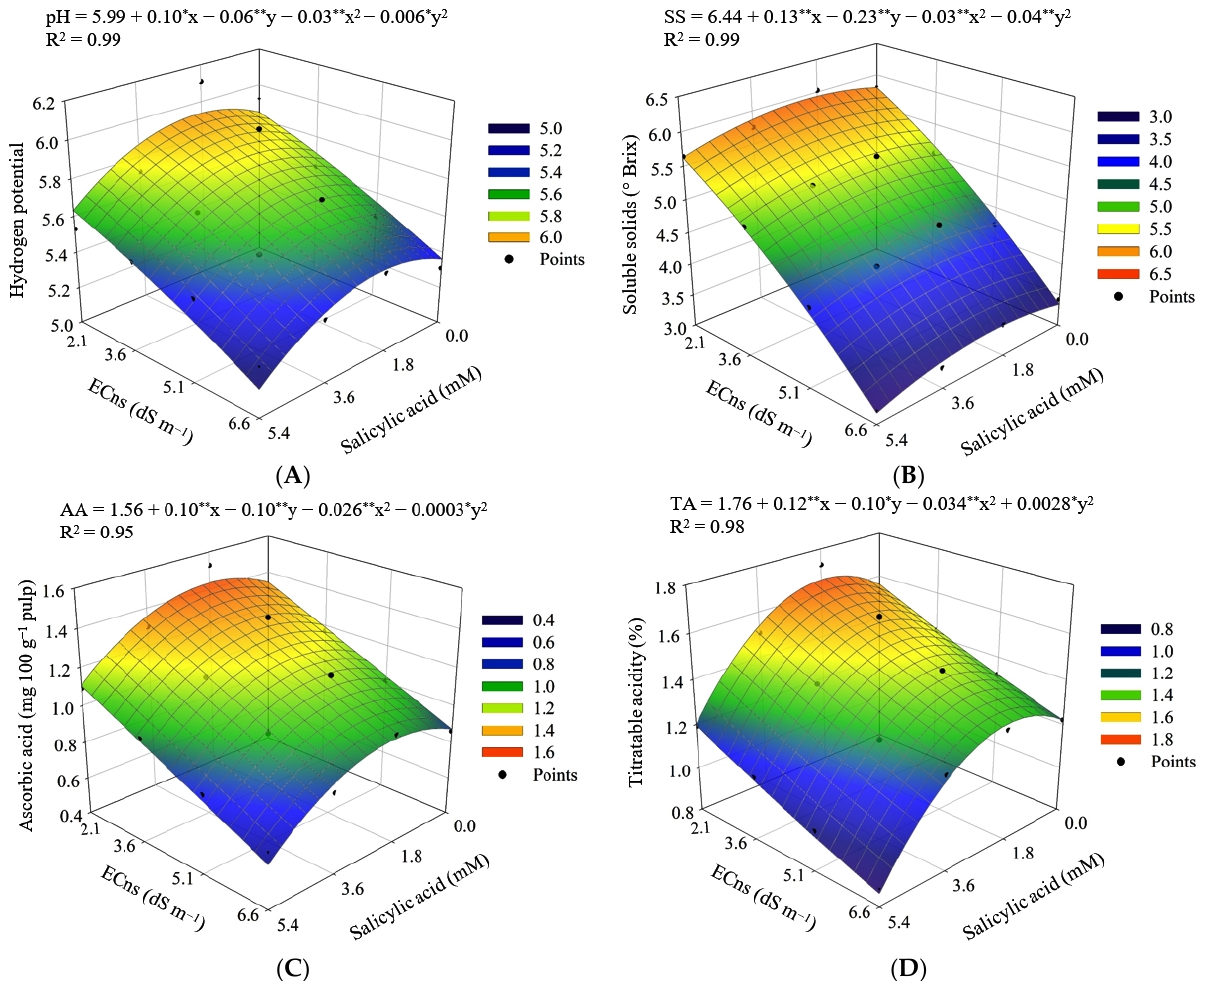
Figure 11. Response surface for hydrogen potential—pH ( A ), soluble solids—SS ( B ), ascorbic ac- id—AA ( C ), and titratable acidity—TA ( D ) of fruits of Japanese cucumber as a function of the in- teraction between the electrical conductivity of the nutrient solution (ECns) and the concentrations of salicylic acid (SA), grown in a hydroponic system, 45 days after transplanting. X and Y—concentration of SA and ECns, respectively; * and ** significant at a p ≤ 0.05 and p ≤ 0.01, re- spectively.